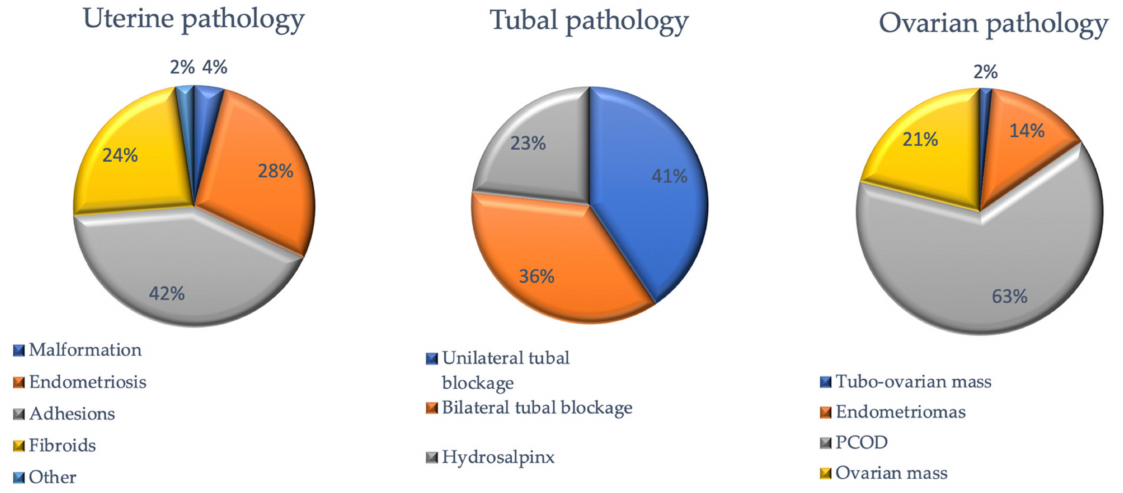
Figure 2. Distribution by type of anomalies on uterine, tubal, and ovarian pathology across the selected